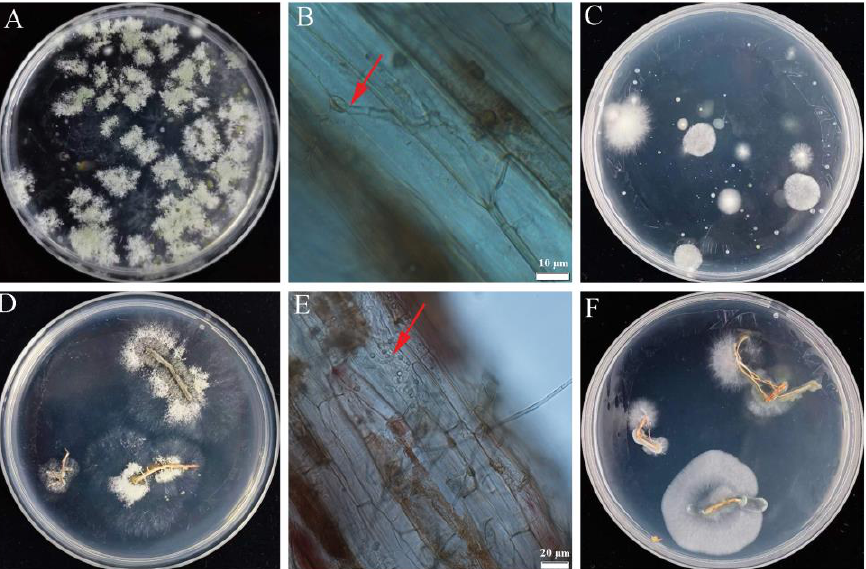
Figure 11. Isolation of Trichoderma from cowpea roots and rhizosphere and spore germination in roots. ( A ) Isolation of HL167 from treated plant rhizosphere soil, ( B ) spore germination of HL167 in treated cowpea root, ( C ) rhizosphere soil of untreated plants did not show HL167 isolation, ( D ) isolation of HL167 from treated plant roots, ( E ) spore germination of HL167 in treated cowpea root, and ( F ) roots of untreated plants did not show HL167 isolation. Red arrow: germination and colonization of Trichoderma spores in cowpea roots.